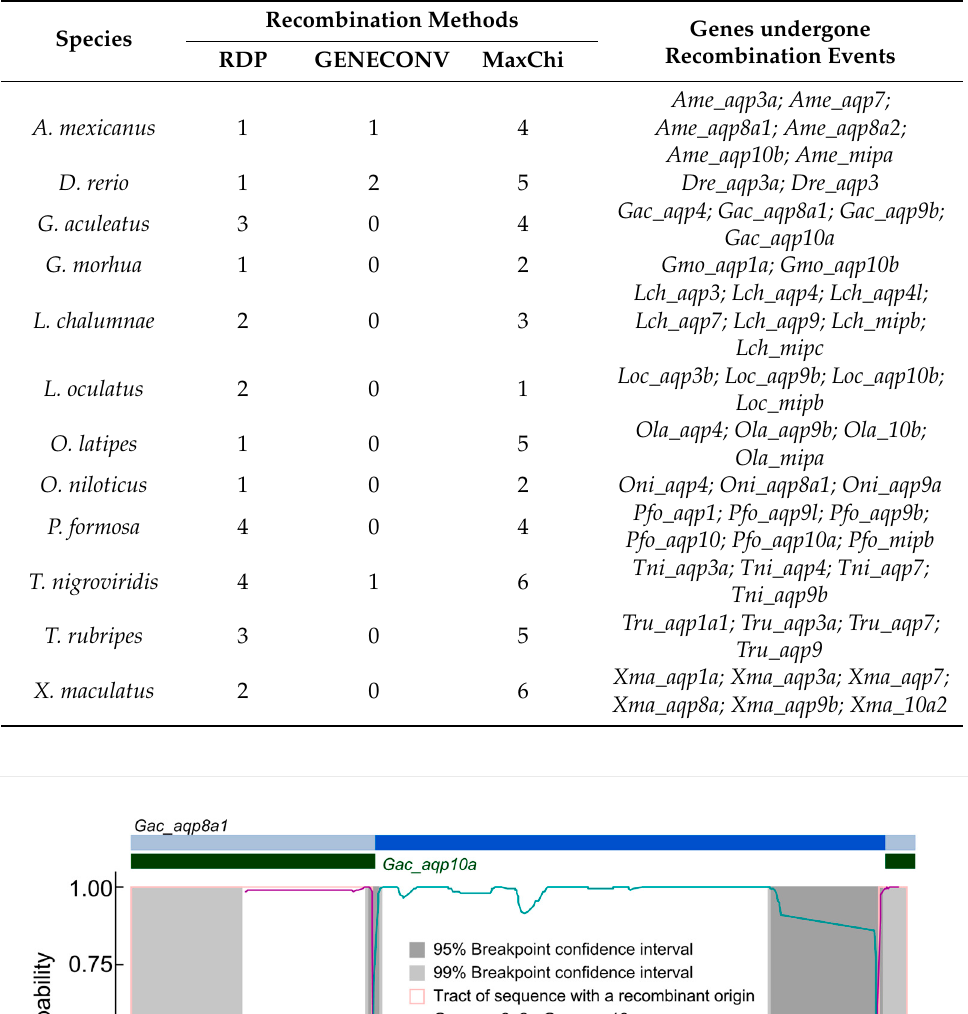
Table 1. The predicted recombination events of the Aqp genes in the twelve fishes.